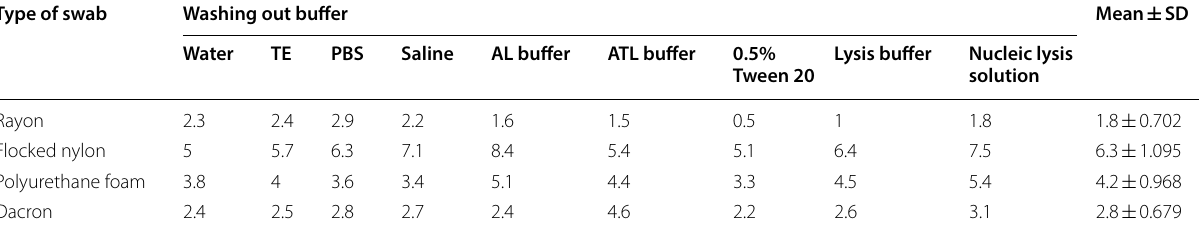
SD standard deviation